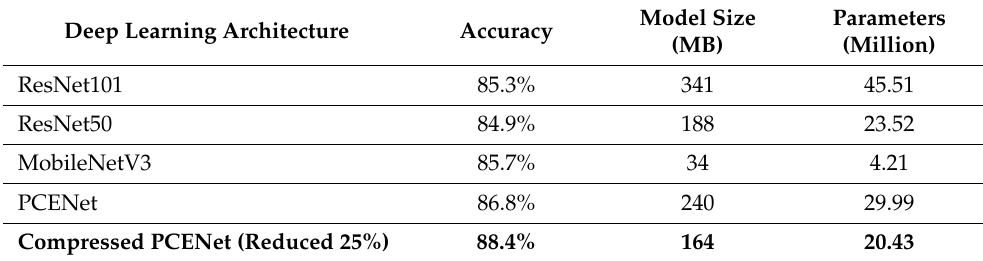
Table 2. Accuracy comparison among several deep learning models.